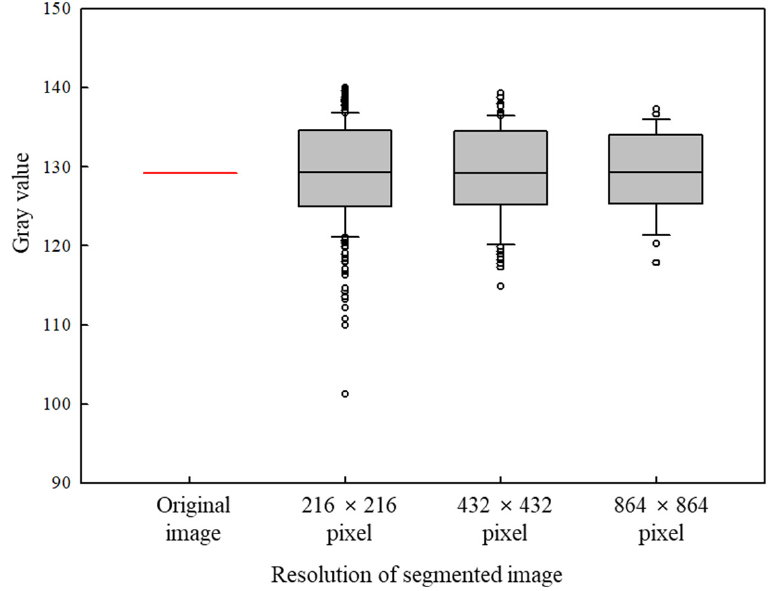
Figure 8. Distribution of average gray value of soil surface images. The solid red line is the average gray value of the original image, and the number of segmented images for each resolution was 384, 96, and 24, respectively.